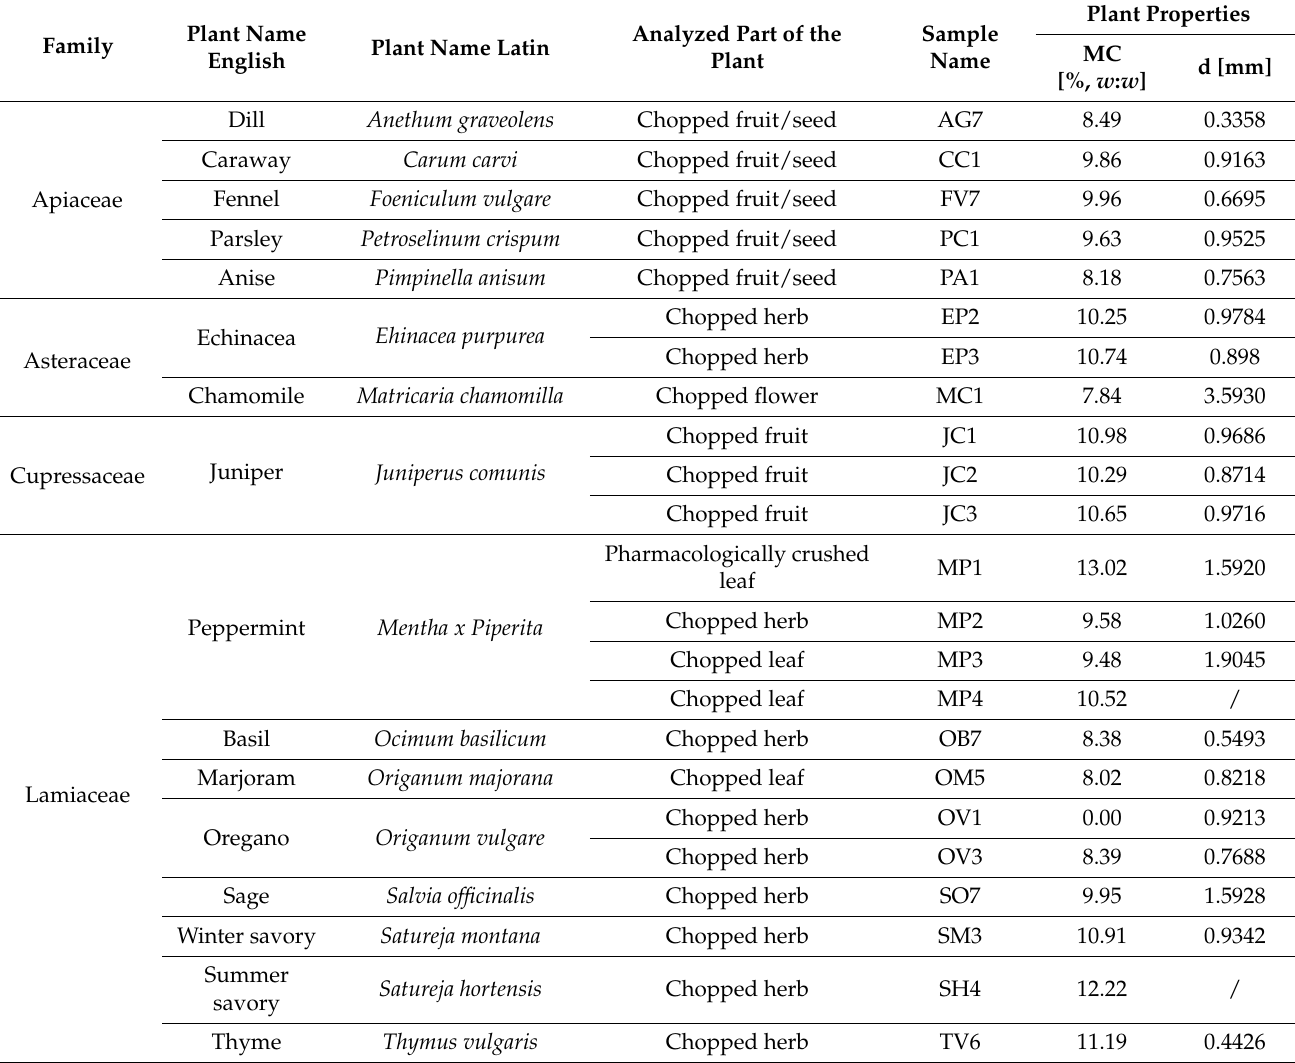
Table 1. Plant material